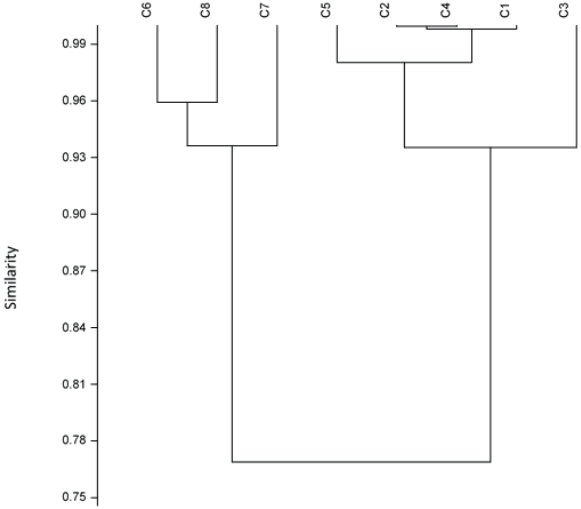
Figure 4 - Cluster analysis (using UPGMA with Cosine similarity measure) applied for the actual metal concentrations of the eight streams. Cophenetic correlation: 0.87. Streams C1 to C5 are located in sugarcane cultivation areas. Strems C6 to C8 are located in preserved areas. Streams detailed information in Table